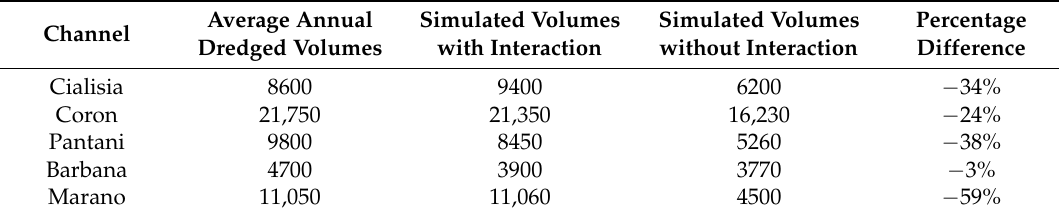
Table 3. Comparison between the simulated deposited volumes (m 3 ) of cohesive sediments with and without the interaction between waves and current velocities with the average annual dredged volumes and the percentage differences between the two